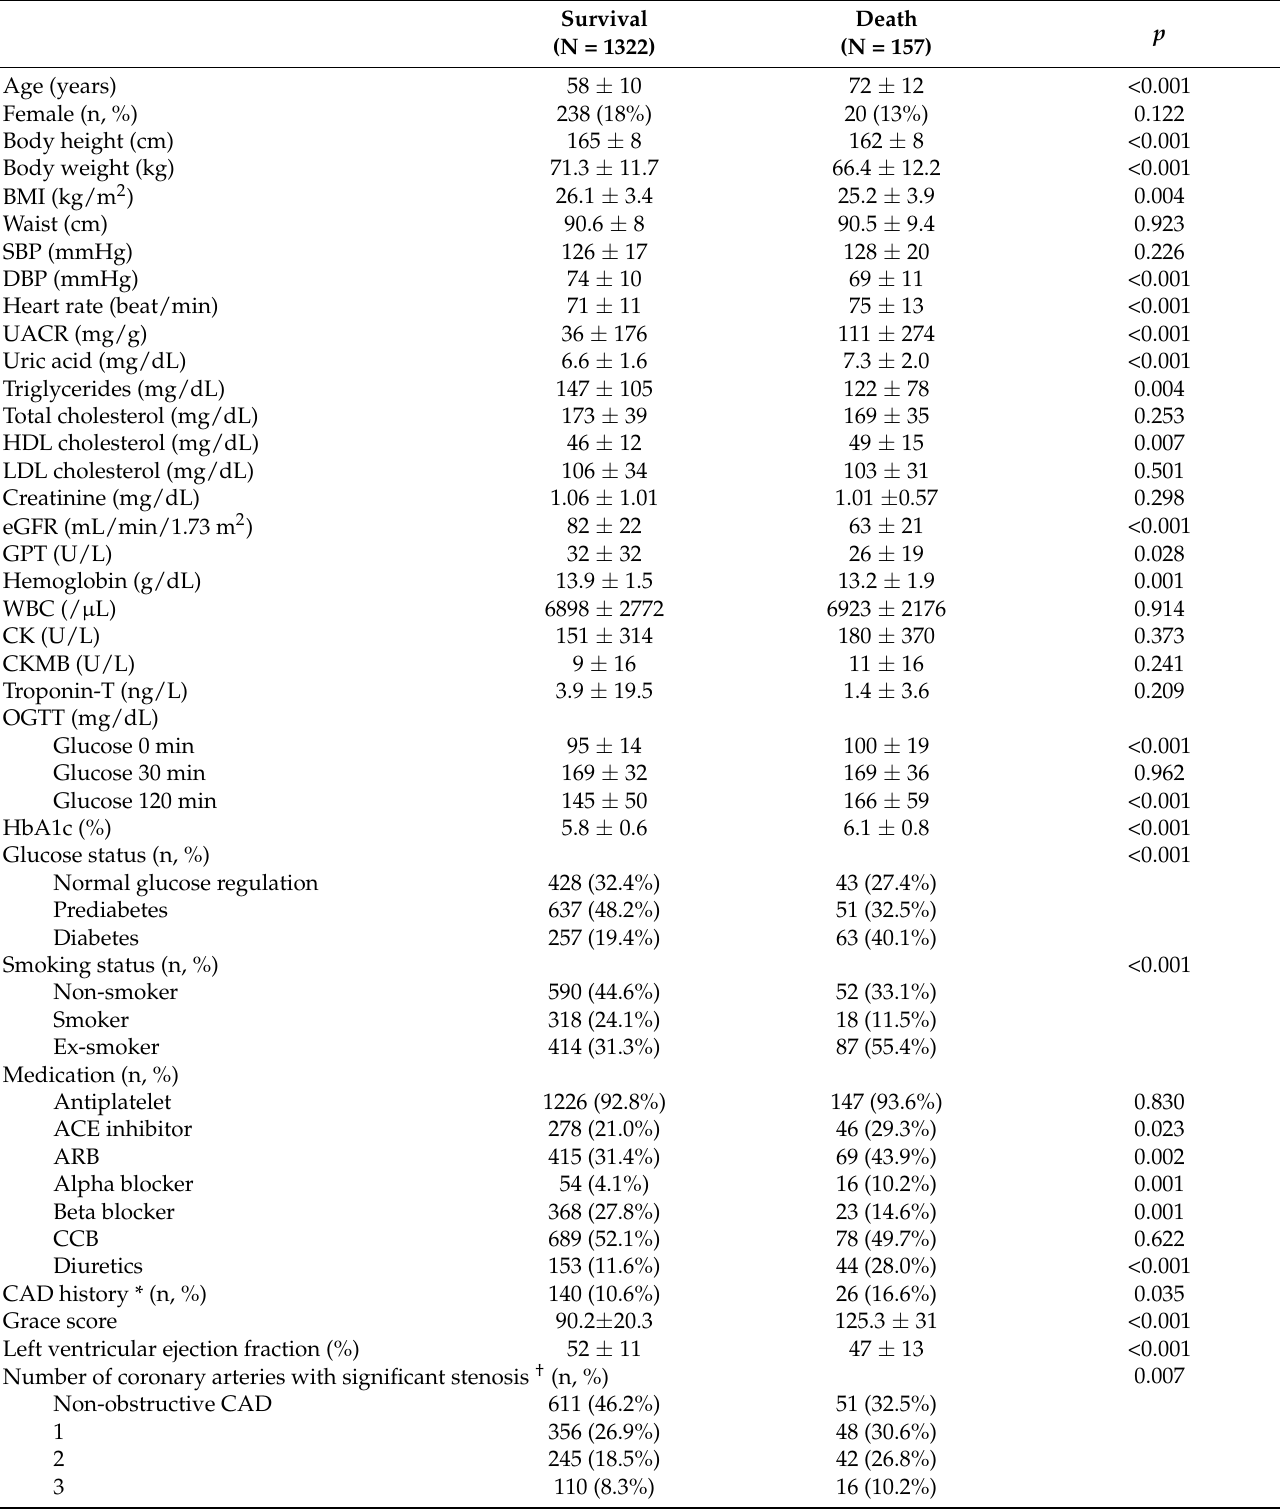
Table 1. Baseline characteristics of the study